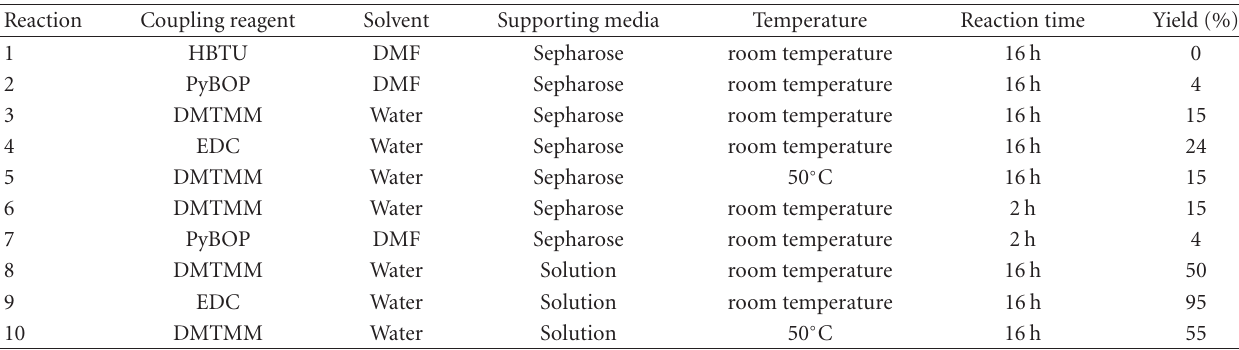
Table 1: Reaction yields for POC formation in the listed